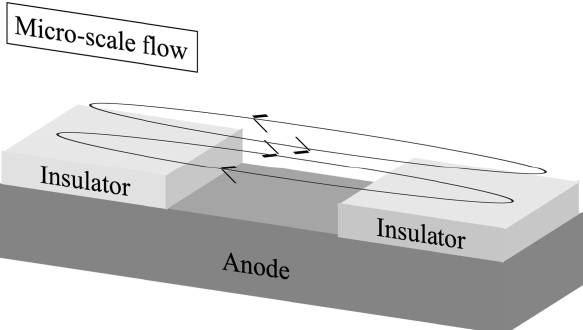
Figure 7. Liquid flow pattern under 2 Hz, 50 mA condition from 5 s to 20 s in the y -range of 120 μm to 280 μm .